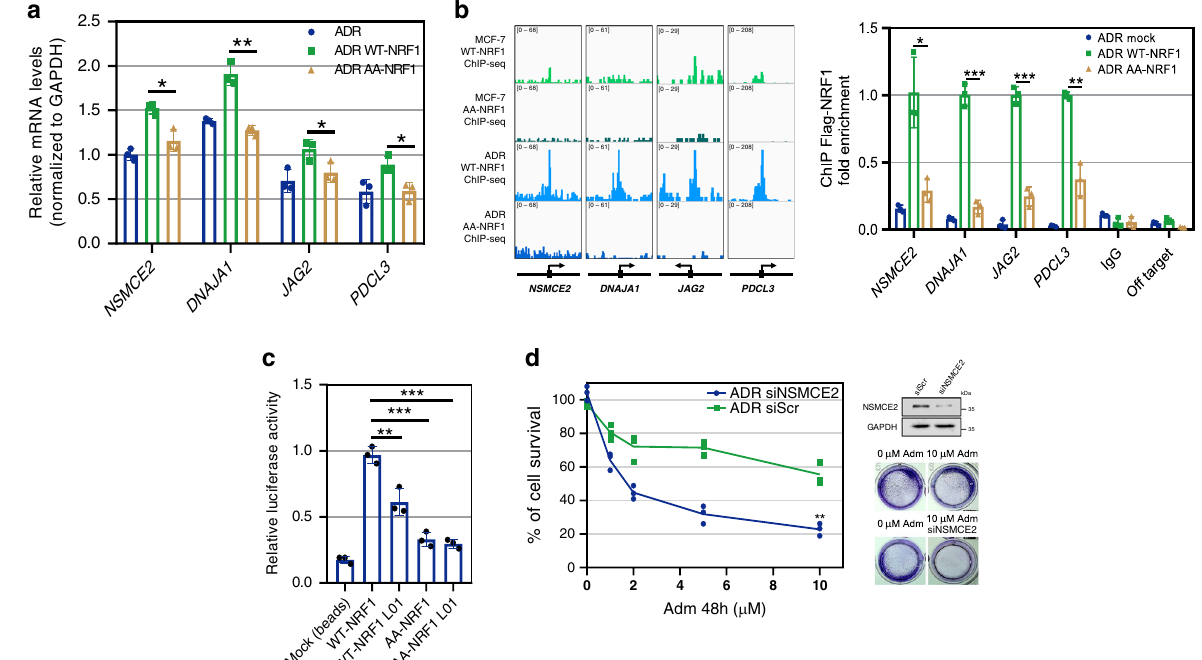
Fig. 8 O-GlcNAc NRF1 increases the pool of gene transcription to protect cells against genotoxicity. a Effect of NRF1 O-GlcNAc modi fi cation on the indicated gene transcription levels in ADR cells. The gene mRNA levels in ADR cells expressing Flag-WT-NRF1 or Flag-AA-NRF1 were analyzed by quantitative PCR (qPCR). b Left panel: IGV tracks showing the signals at the promoter regions of the representative genes. Right panel: Validation of O- GlcNAc NRF1 binding peaks by ChIP-qPCR. qPCR ampli fi cation was performed. Each bar represents the fold enrichment of binding relative to the input. IgG and random primers that could not speci fi cally bind the indicated gene promoter regions (off target) were used as negative controls. Mock, cells transfected with empty pCMVPuro64 vector. c O-GlcNAc inhibition reduces the transcriptional activity of NRF1. 293T cells were transfected with a reporter vector consisting of luciferase cDNA fused to the NSMCE2 promoter. The pGL3-basic vector (Mock) was used as a control. d ADR cells were transfected with NSMCE2 siRNA (siNSMCE2) or scrambled siRNA (siScr) and treated with increasing doses of Adm for 48 h. The cell viability was then assessed. Representative images of cell viability determined by crystal violet staining are shown. Results were reproduced in two biologically independent experiments. The protein levels of NSMCE2 were monitored by immunoblotting. All blots are representative of at least two biologically independent experiments. For ( a - c ), the data are presented as the means ± SEM., ( d ) replicates are represented. ( a – d ) n = 3 biologically independent experiments, * p